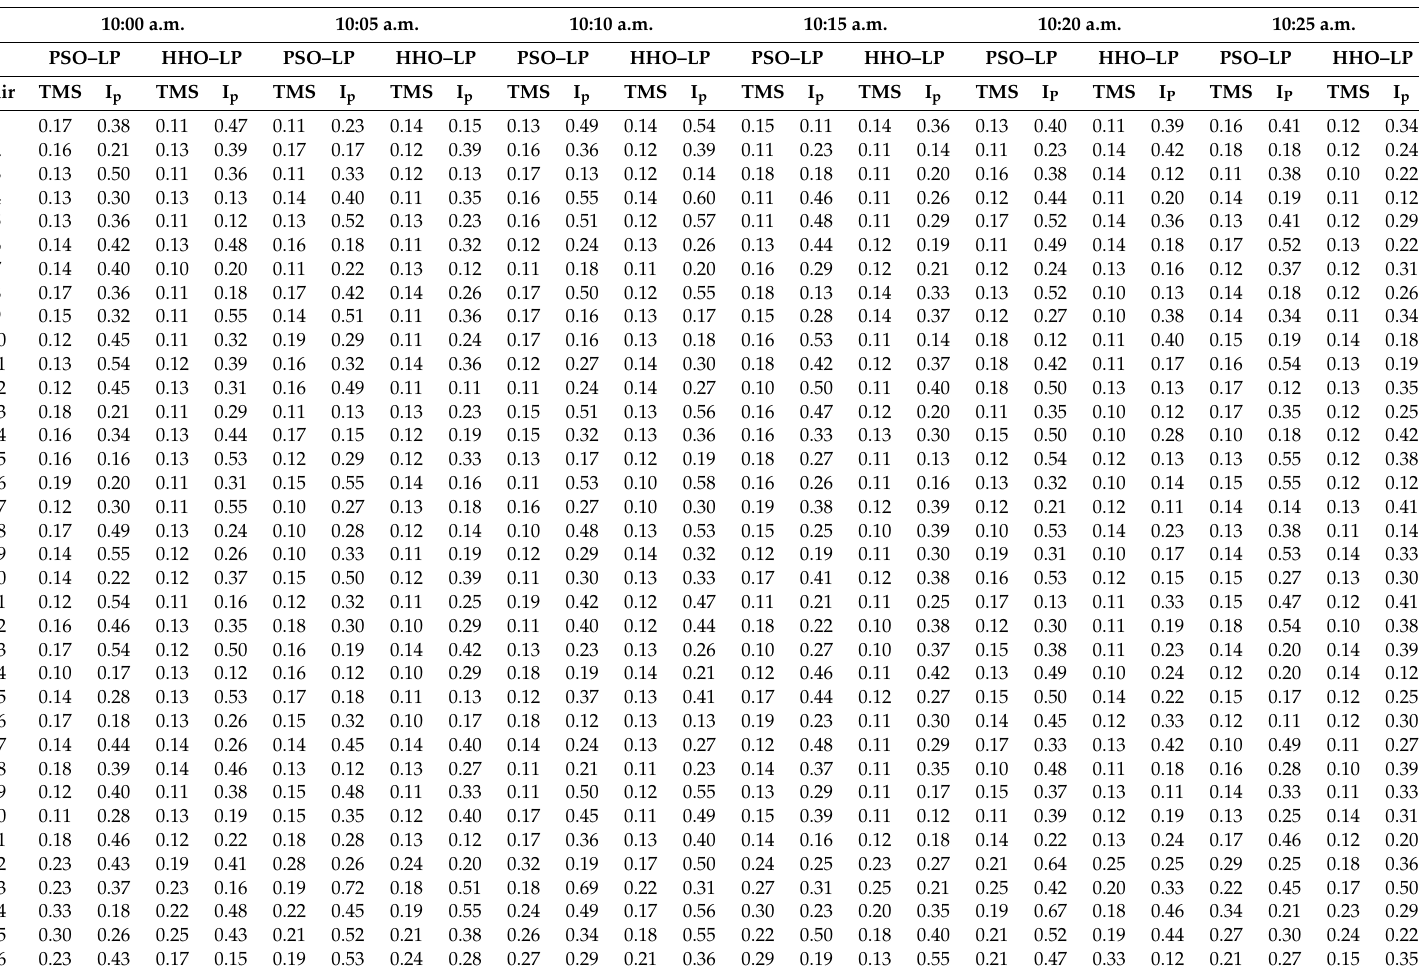
Table 9. Relay settings for 12 intervals of one hour from 10:00 a.m.–11:00 a.m. on 15 July 2019 obtained using PSO–LP and the proposed